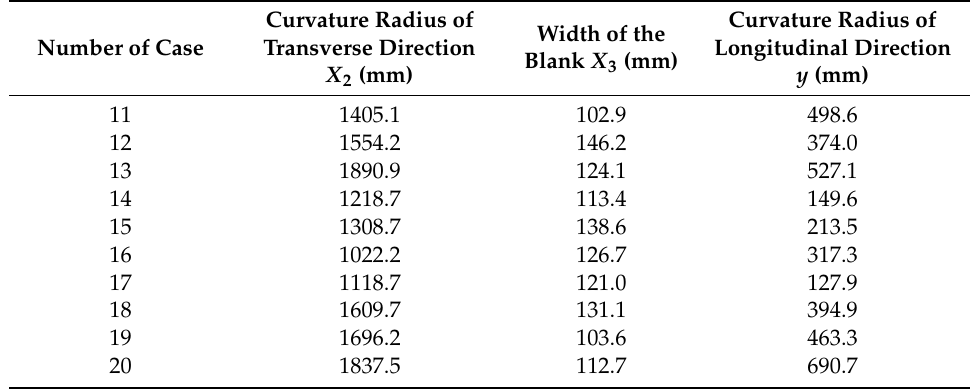
Table 9. Statistical table for the saddle type random sample.